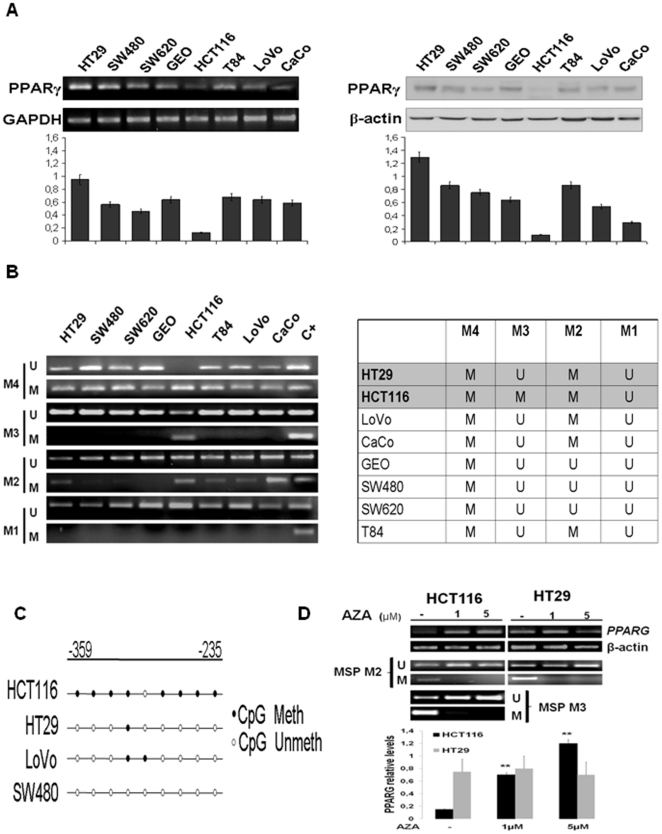
Promoter methylation is associated with reduced PPARG expression levels in CRC cell lines.(A) PPARG mRNA and protein levels detected by RT-PCR ad western blot analysis in a panel of eight CRC cell lines. GAPDH and β-actin were used as controls, respectively. (B) MS-PCR results obtained on the M1–M4 promoter regions analyzed; M, methylated; U, unmethylated; C+ indicates methylated and unmethylated controls. The methylation status of all CRC cell lines analyzed is summarized, with HCT116 and HT29 cells depicted in grey. (C) CpG dinucleotides methylation was assessed by BS. The results of some representative cell lines are reported. Methylated or unmethylated CpG dinucleotides are depicted as black or white circles, respectively. (D) Pharmacologic demethylation induced PPARG expression in HCT116 while no significant difference was found in HT29 cells used as control. Cells were exposed to 1 and 5 µM AZA for 72 hs, MS-PCR was carried out on the M2 and M3 regions, before and after treatment, **P<0.01.